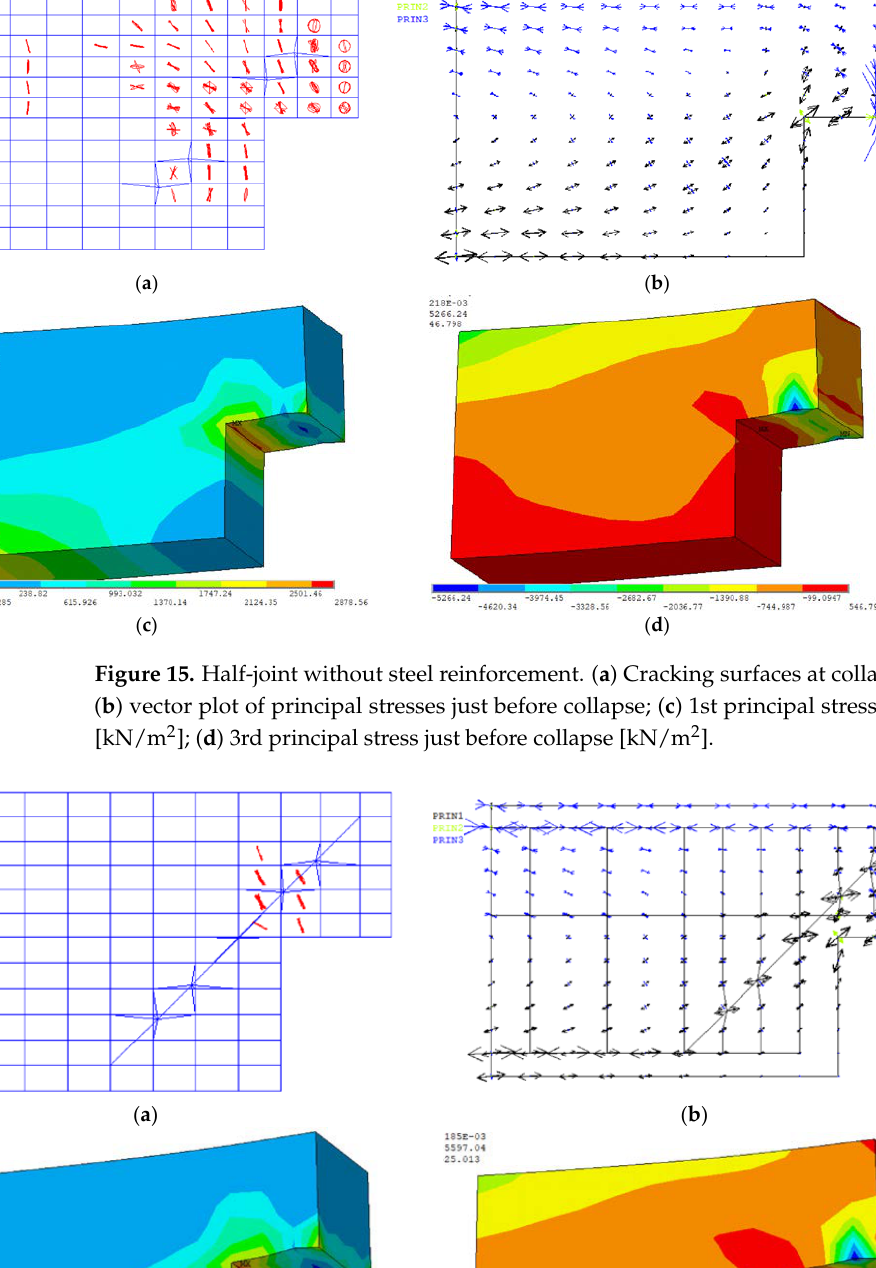
12 of 17 Figure 14. Boundary condition of the FE model.